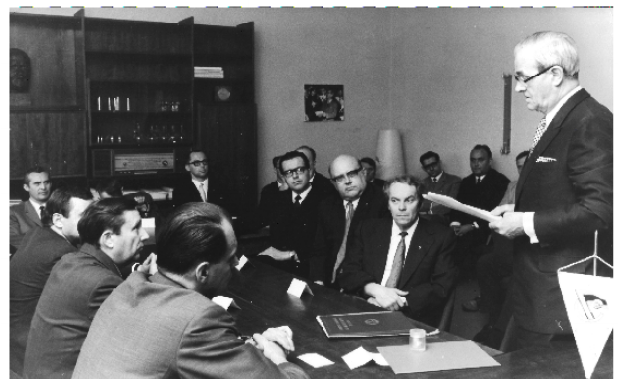
Figure 22. Handing over the lunar material (standing Prof. Klare, President of Academy of Sciences, left Prof. Stiller).